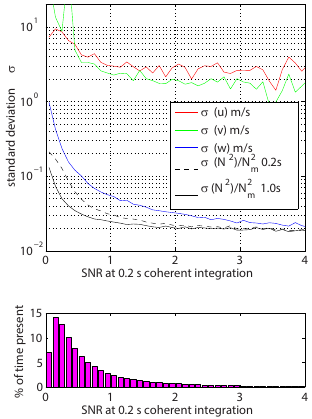
Figure A1. Standard deviation of measured parameters as a func- tion of SNR, and distribution of SNR, for ESRAD using experiment mode fca_150, altitudes 11–13km (based on 1min data records covering the whole month of April 2009). u , v and w are zonal, meridional and vertical wind components, respectively, using 0.2s coherent integration. N is buoyancy frequency. Dashed and solid black lines show results for N 2 using 0.2s and 1.0s coherent inte- gration times,